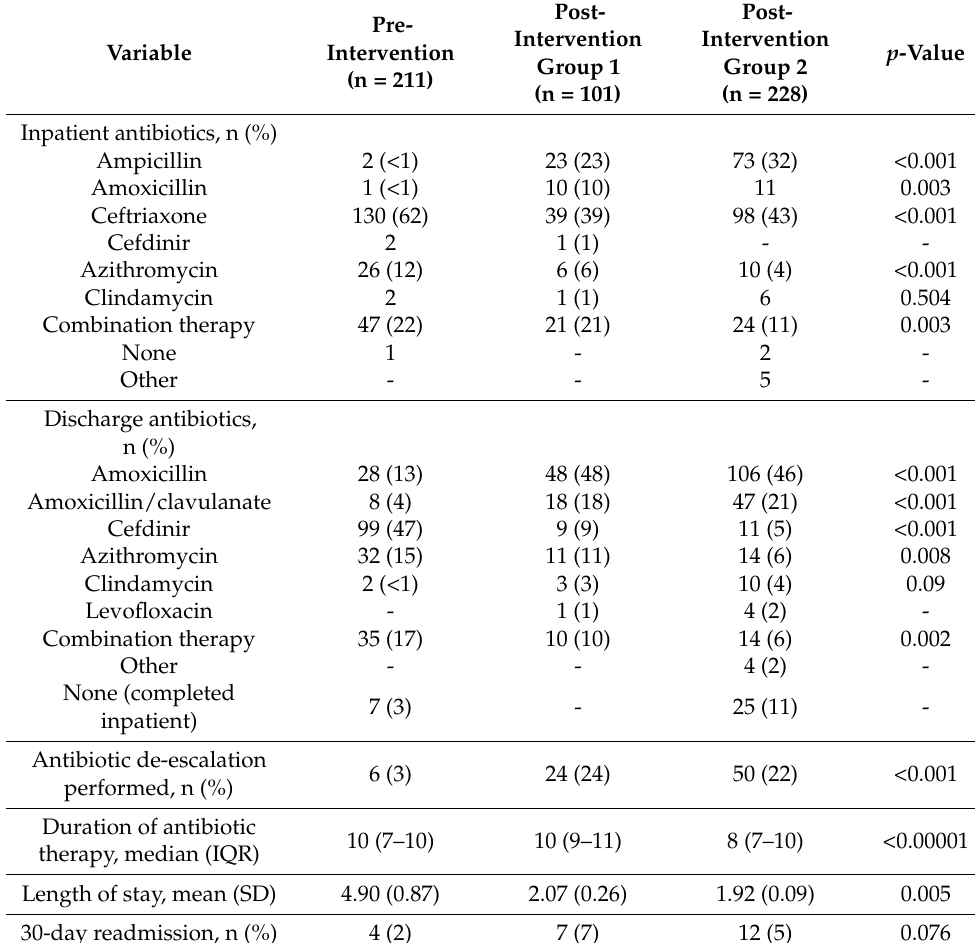
Table 2. Treatment characteristics and clinical